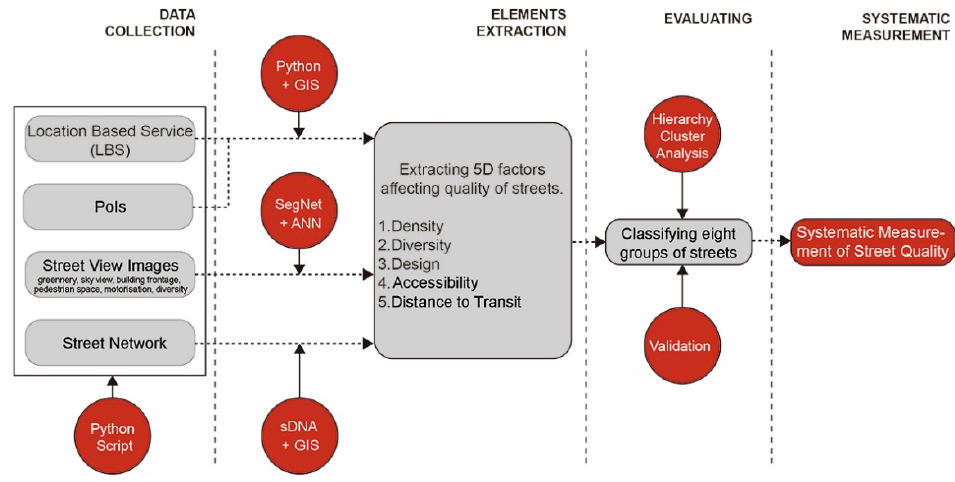
Figure 1. Analytic framework.